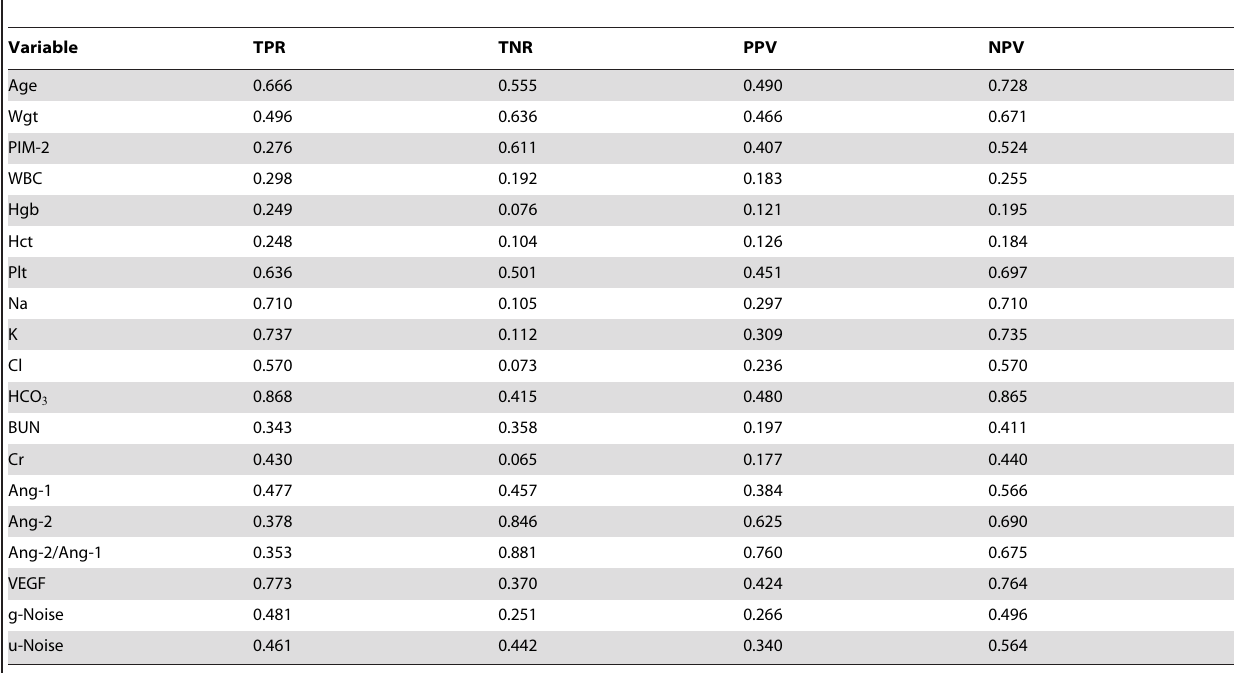
Table 2. Prediction measures for single biomarker from Support Vector Machine.